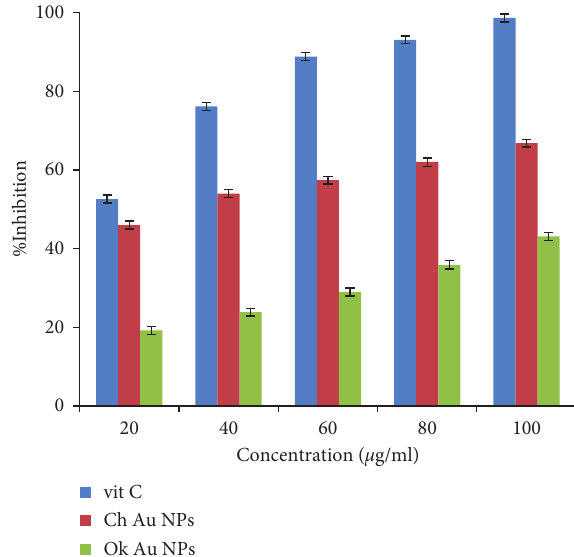
Figure 7: Antioxidant activity of Ch Au NPs, Ok Au NPs, and Vit C.